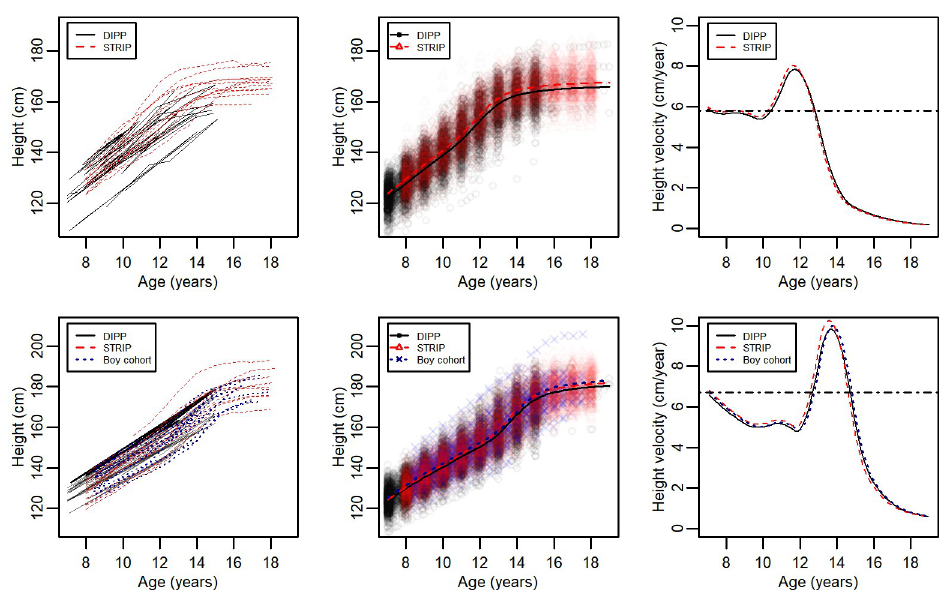
Fig 2. For girls (above) and boys (below): a) Observed growth for 15 randomly selected children from every cohort, b) SITAR-based cohort-specific average growth curves with height measurements, and c) SITAR-based growth velocity